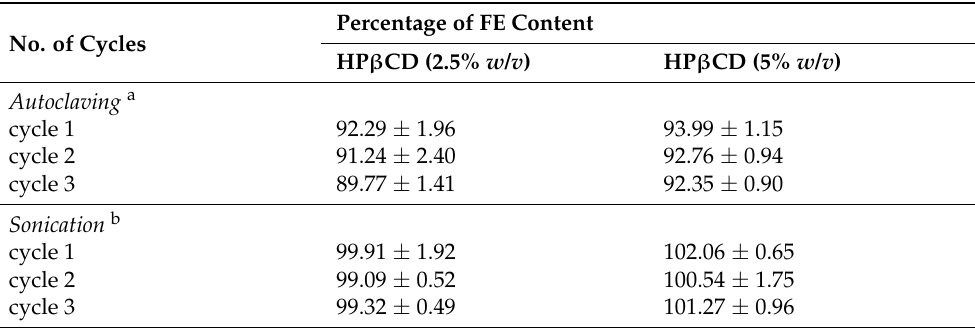
Table 1. The percentage of FE remaining in aqueous 2.5% w / v and 5% w / v HP β CD solutions after zero to three heating cycles in an autoclave or ultrasonic